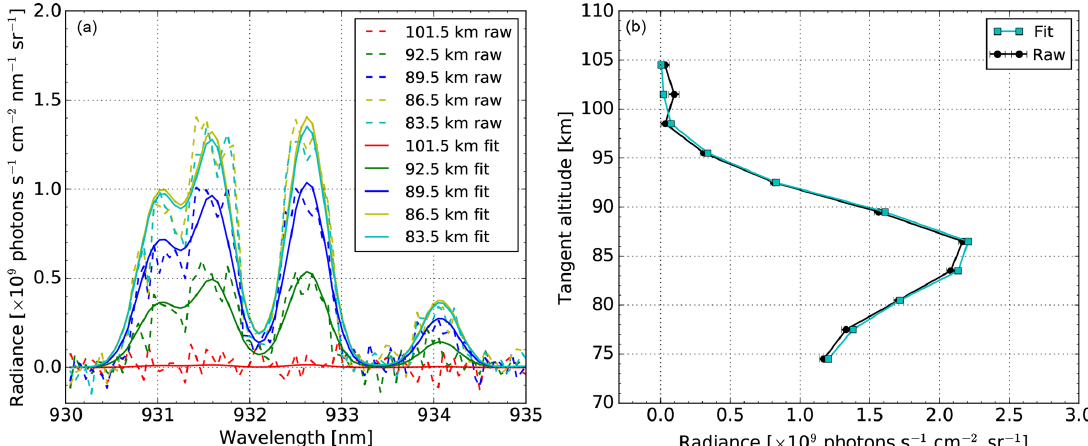
Figure 5. (a) Simulated spectra (fit, solid line) and measurements (raw, dashed line) of GOMOS monthly zonal mean measurements of OH(8–4) airglow emissions at tangent altitudes, as given in the figure legend for August 2003 at 30–40 ◦ S and a local time of 22:00–00:00LT. (b) The spectrally integrated radiance over 930–935nm versus tangent altitude for the same conditions.